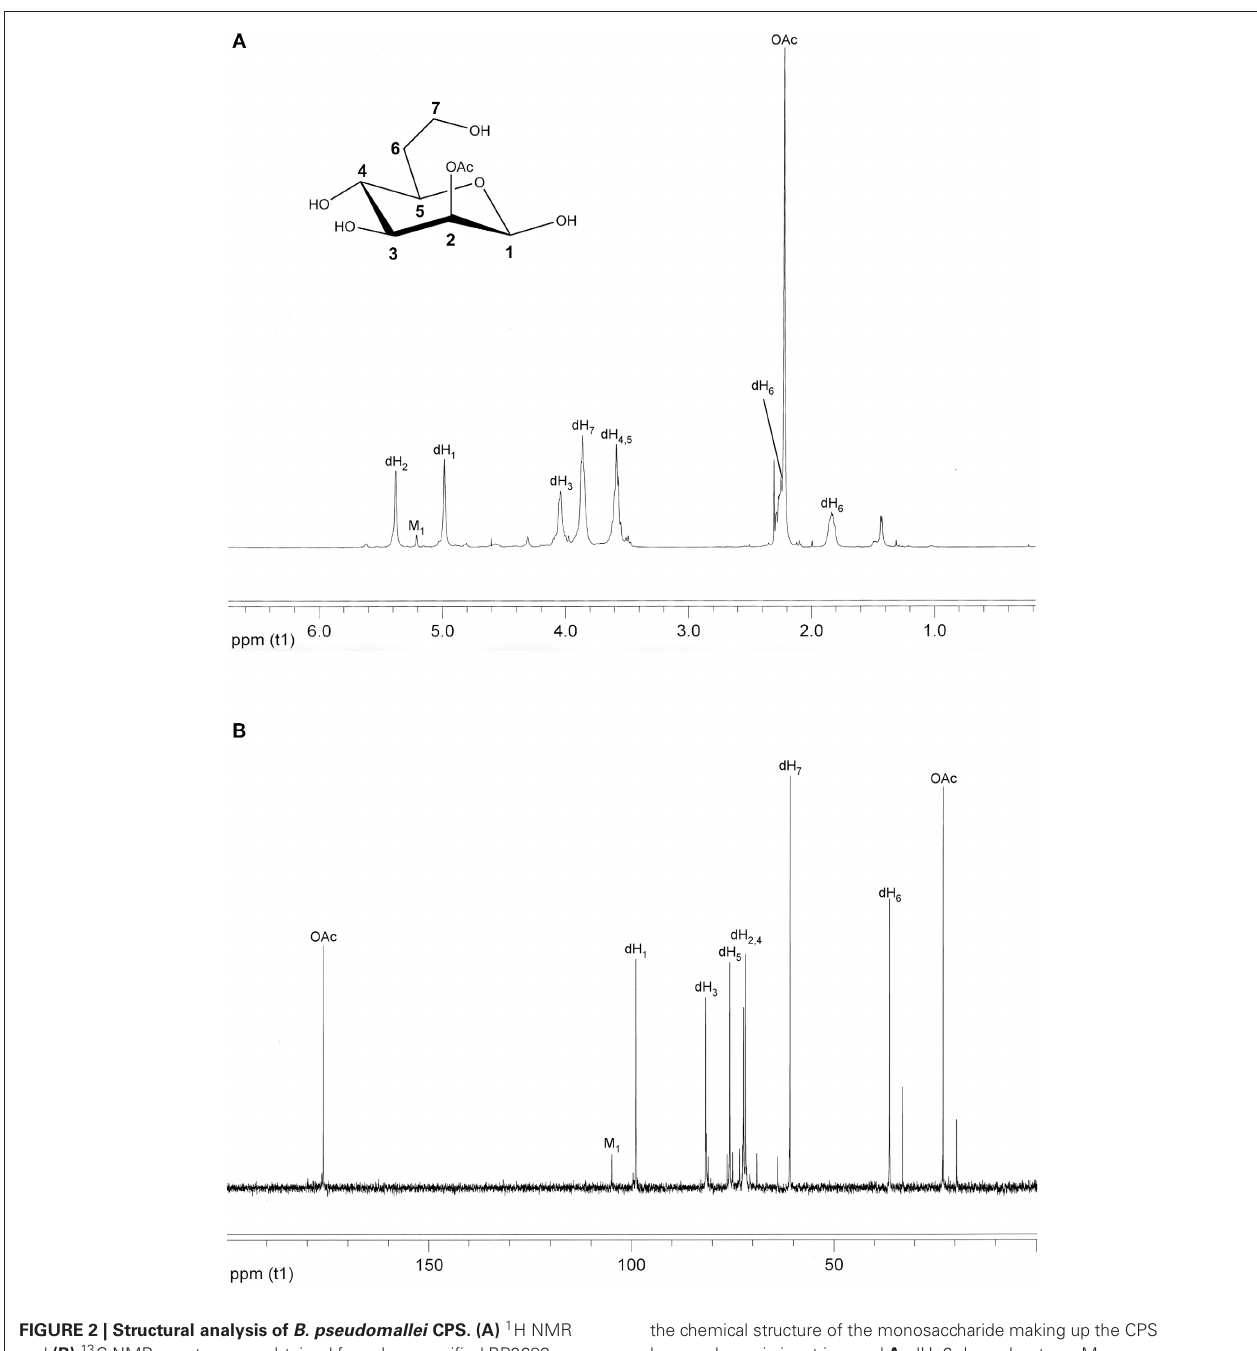
FIGURE 2 | Structural analysis of B. pseudomallei CPS. (A) 1 H NMR and (B) 13 C NMR spectra were obtained for column purified BP2683 CPS using a Varian Inova-500 MHz spectrometer. For reference purposes,